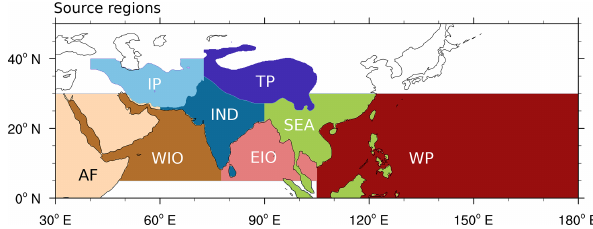
Figure 1. Source regions based on ERA-Interim orography and land–sea mask data at 0 . 125 ◦ × 0 . 125 ◦ grid spacing for the TRJ calculations. See text for